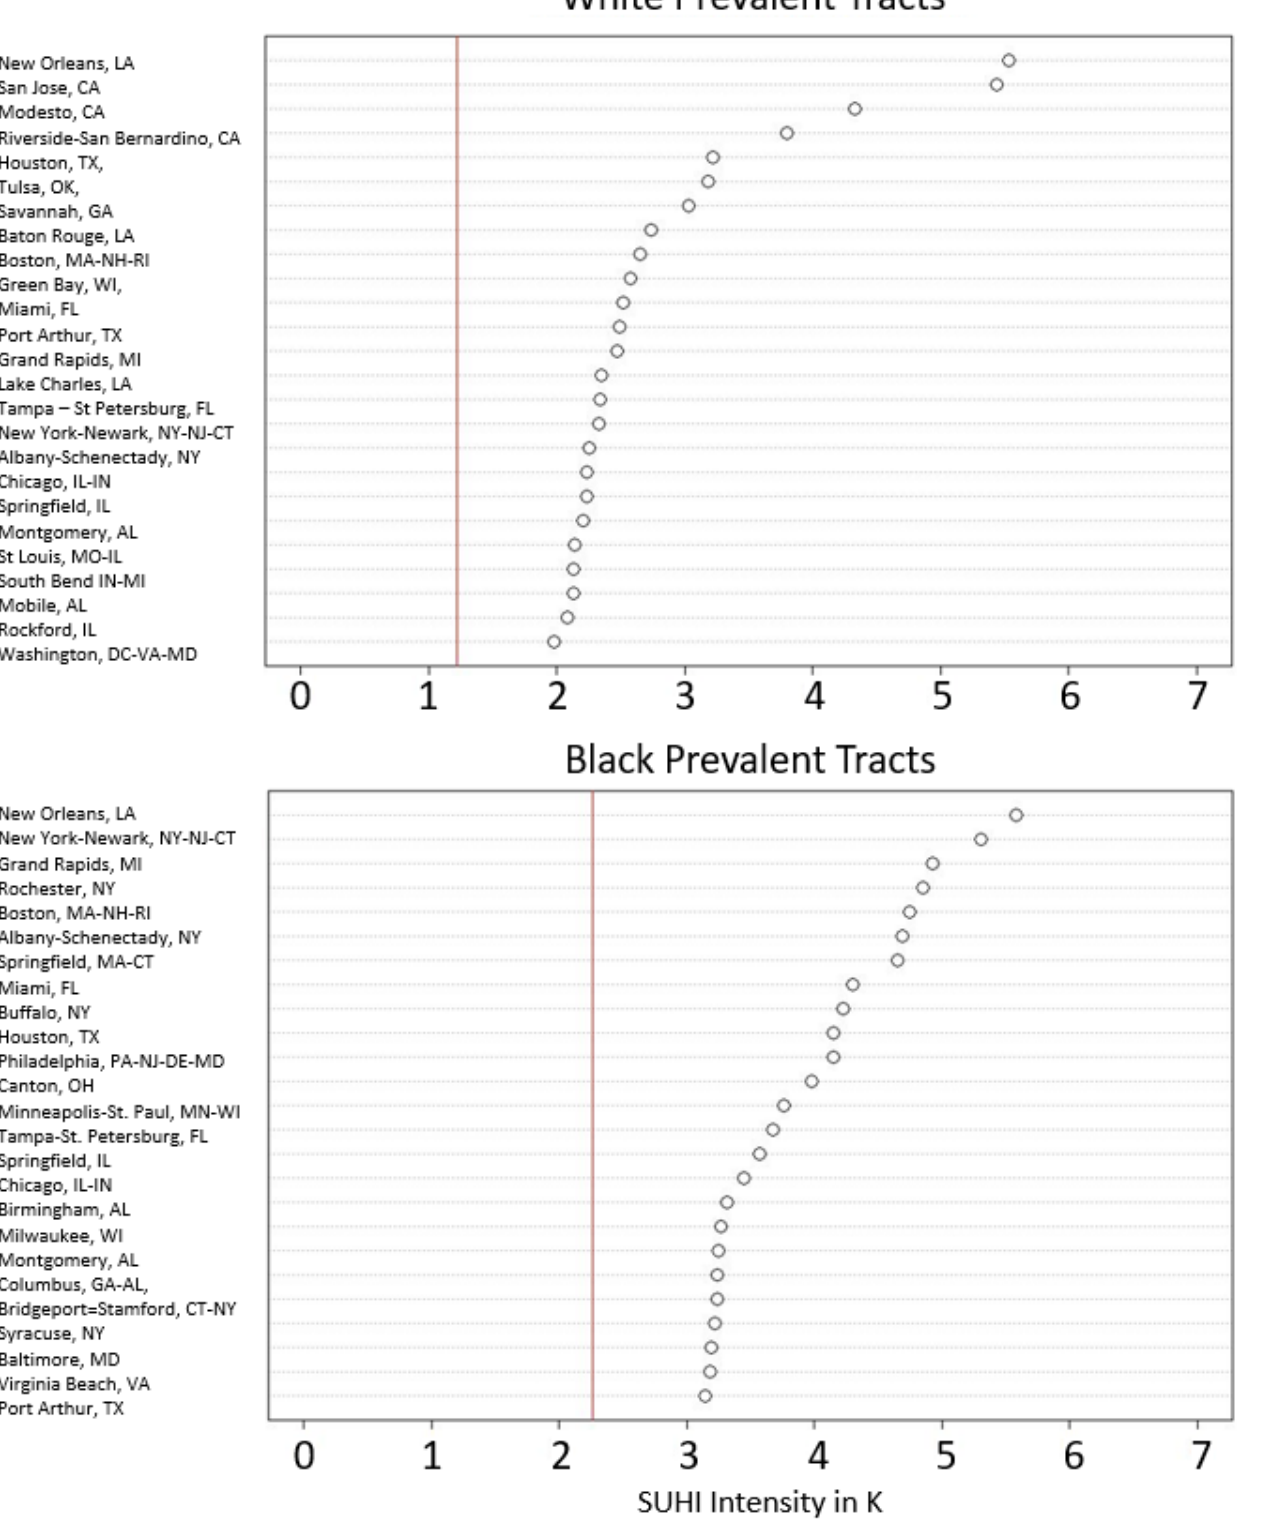
Figure 4. Top 25 cities ranked by highest SUHI intensity for census tracts classified as White and Black prevalent. Circle is the average SUHI intensity for the prevalent tracts of the respective city. Red vertical line represents the overall average SUHI intensity for the prevalent tracts of the demographic group. (Note: Black, Asian, and Hispanic prevalent tracts did not exist in all cities, however, each city did contain White prevalent tracts)